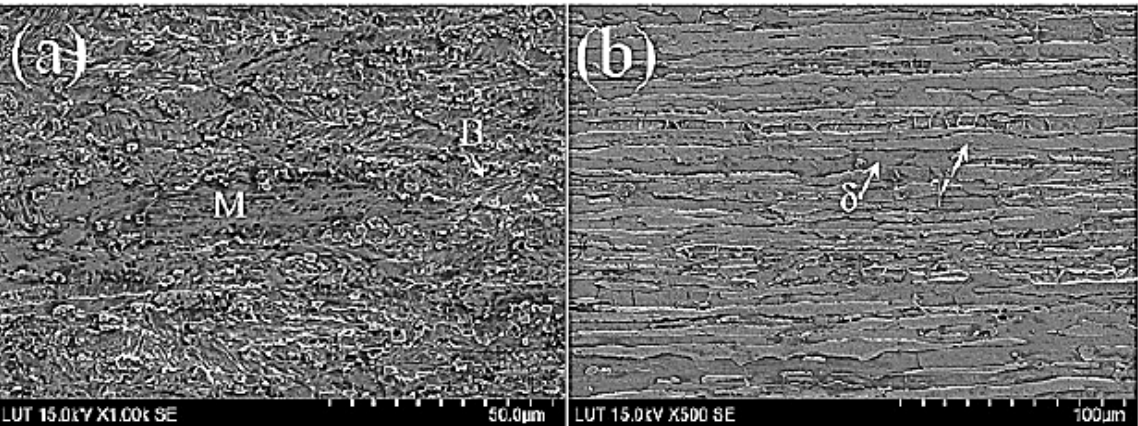
Figure 7: Microstructure of weld sample: (a) S960 and (b) S32205: Reprinted with permission from Tasalloti et al. // Material Characteriza- tion, 123 (2016). ©2016 Elsevier Inc. All rights